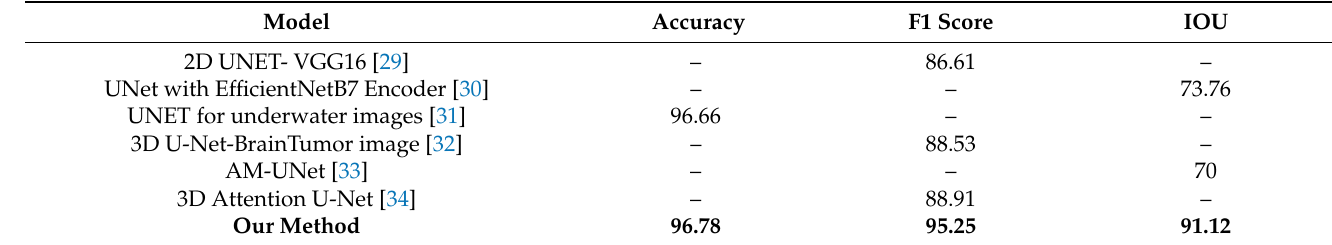
Table 8. Performance result comparison with different existing methods.